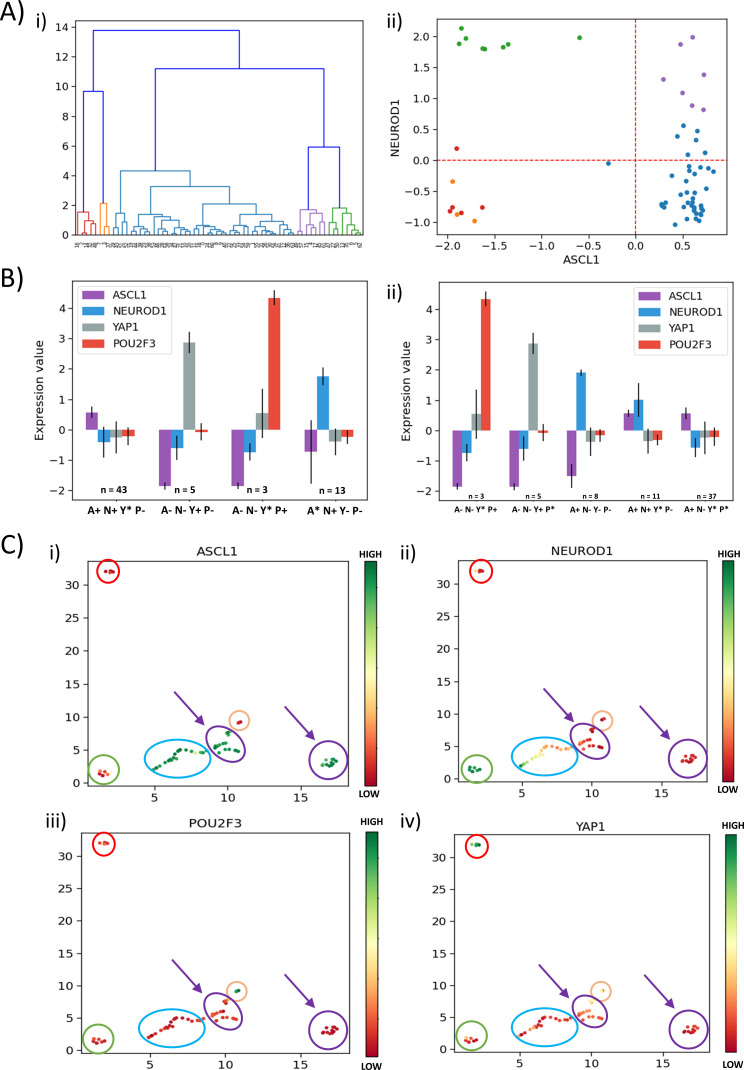
Analysis for GSE73160 using ASCL1, NEUROD1, POU2F3, and YAP1.(A) (i) Hierarchical clustering of GSE73160 dataset across ASCL1, NEUROD1, YAP1, and NPOU2F3. (ii) Scatter plot of normalized gene expression for NEUROD1 vs ASCL1 of GSE73160 dataset, labeled by n = 5 clusters obtained from the earlier dendrogram. (B) (i) Expression levels of four classifying genes (ASCL1, NEUROD1, YAP1, and POU2F3) in clusters obtained from the k-means algorithm for k = 4 in the GSE73160 dataset. (ii) Same as (i) but for k = 5. (C) (i–iv) UMAP projection of GSE73160 dataset from four dimensions (ASCL1, NEUROD1, YAP1, and POU2F3) to two dimensions. The labeling is based on expression levels of ASCL1 (i), NEUROD1 (ii), POU2F3 (iii), and YAP1 (iv).